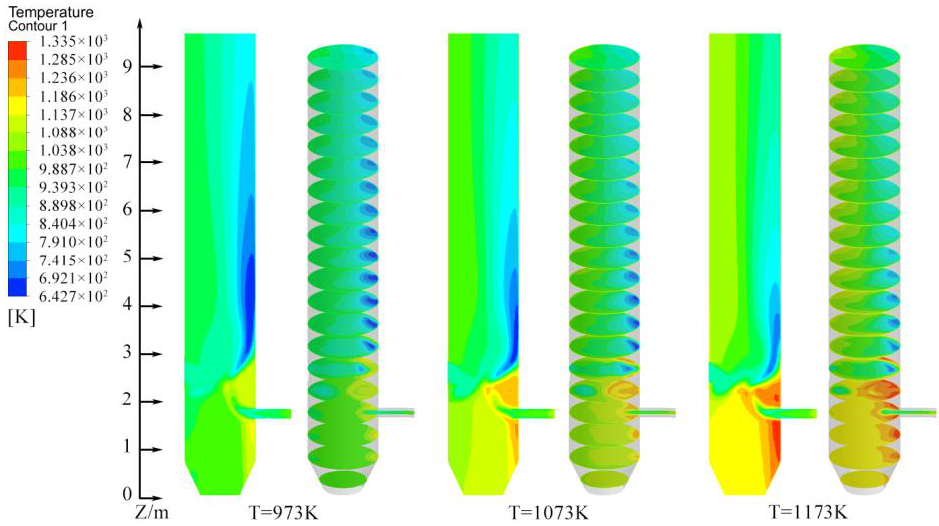
Figure 17. Cloud chart of temperature distribution of sections with different flue gas temperatures X = 0 and Z-axis.